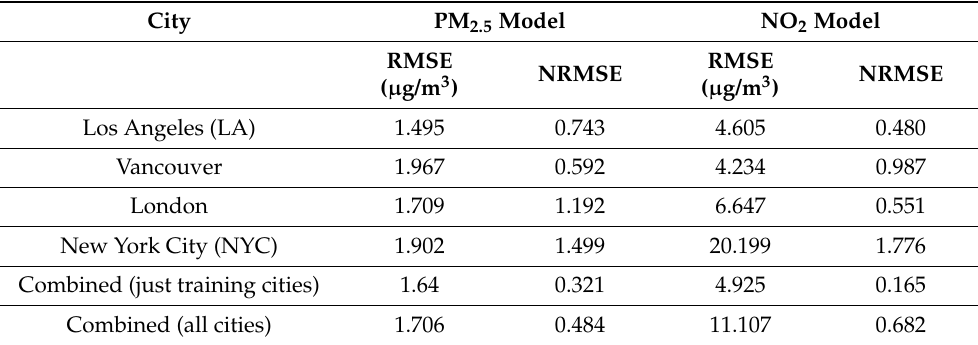
Figure 3. NO 2 target data, model estimates and errors. NO 2 target data ( a ), based on 2010 LUR data in Los Angeles, Vancouver, and London. Column ( b ) shows the 200 m model estimates of NO 2 annual concentrations using the testing dataset (10% of the available data for all cities). Column ( c ) shows the model residuals calculated by the difference between the predicted concentrations and the target data, and the residuals’ distributions are shown in column ( d ). Table 2. PM 2.5 and NO 2 model